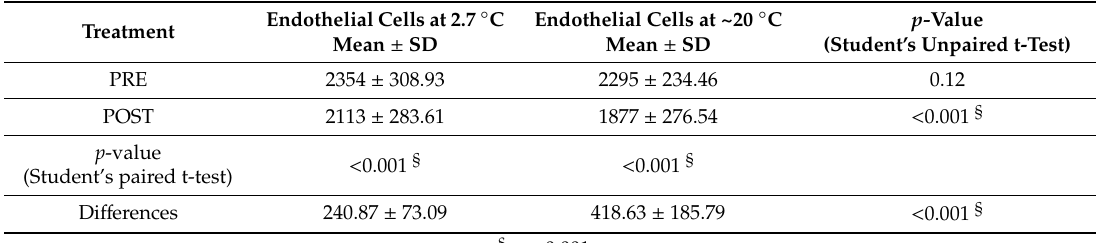
Table 5. Intra- and inter- group statistical di ff erences in endothelial cells for the groups A and B (pre- and post- treatment) and in endothelial cells di ff erences (pre- minus post-